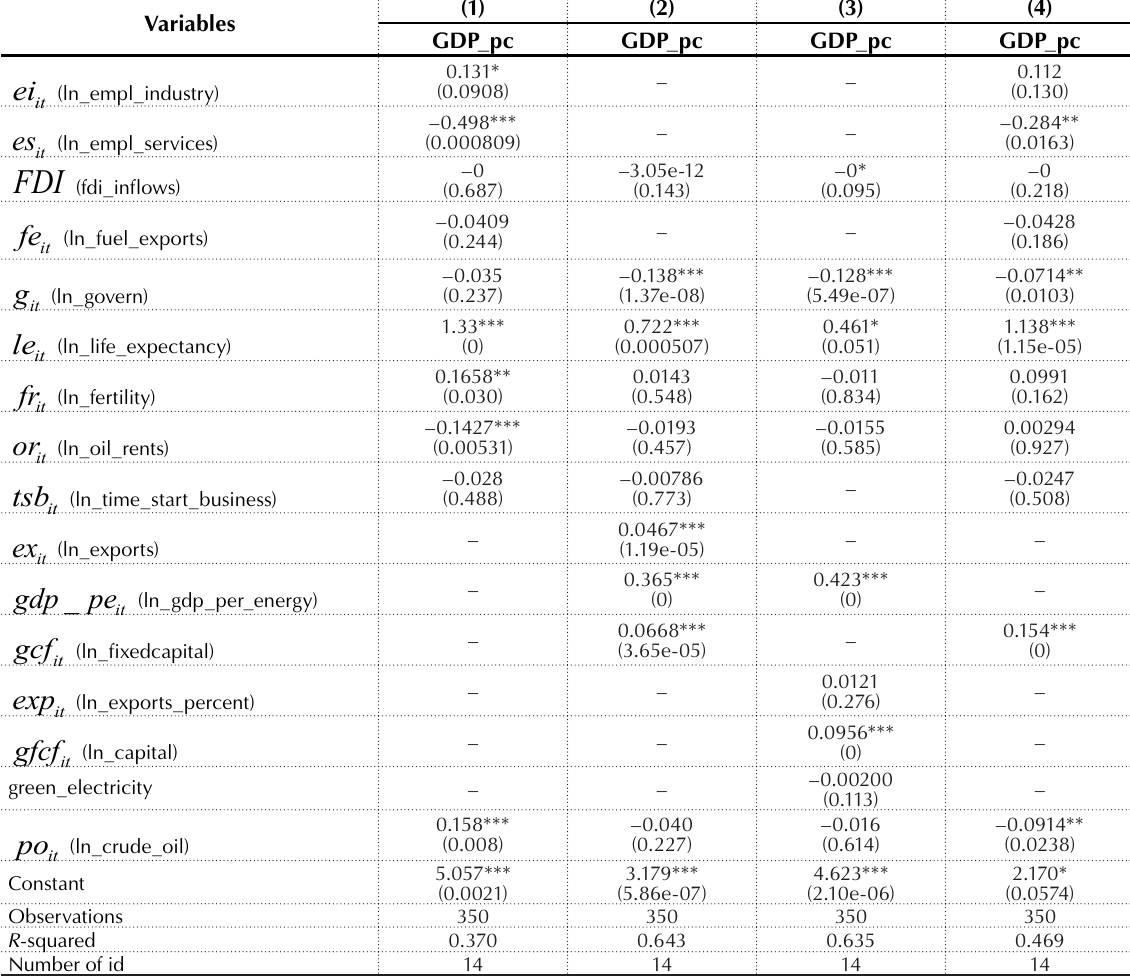
Table 3. The regression analysis of GDP per capita drivers for the panel of 14 OPEC members